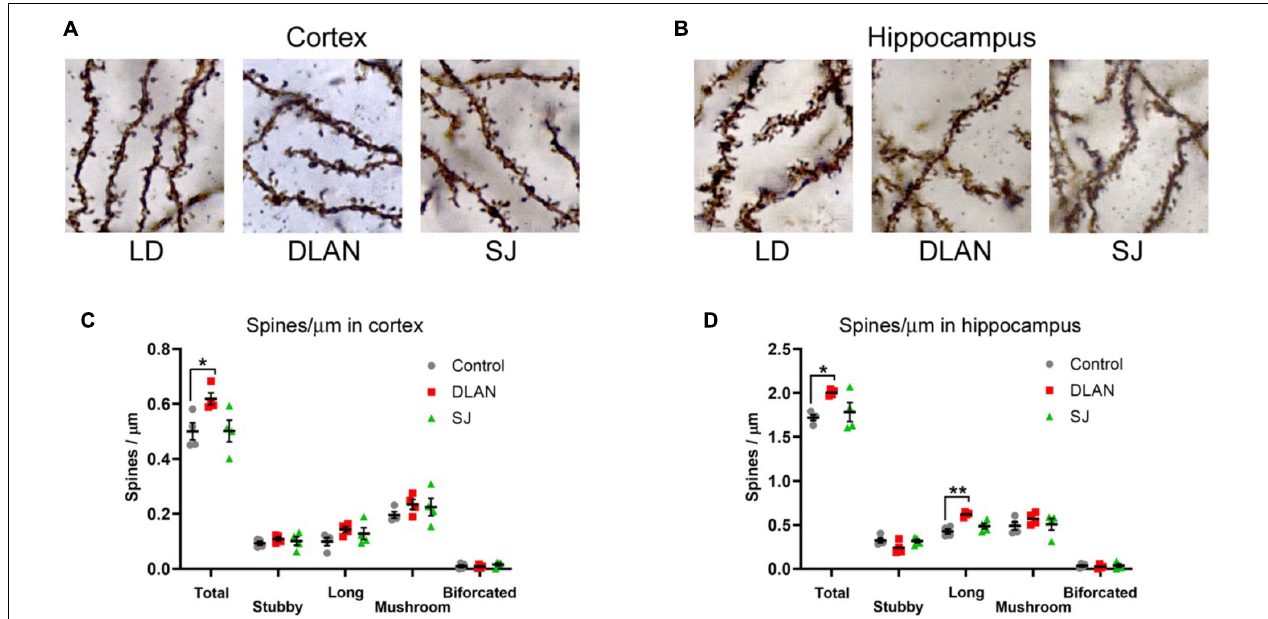
FIGURE 7 | Dendritic spine analysis, following the end of the 12-month lighting disruption period. (A,B) Representative images of dendritic spine visualization in the cortex (A) and hippocampus (B) of mice from disruptive conditions (see Figure 1 for a description of the three groups). (C,D) Quantification of the density of dendritic spines in the cortex (C) and hippocampus (D) , classified by morphology, and total numbers. One-way ANOVA (with Welch correction, or Kruskal-Wallis test when appropriate), groups: LD, DLAN, SJ. Post-hoc tests conducted with Benjamini-Hochberg corrections when appropriate. ** p < 0.01 and * p < 0.05.